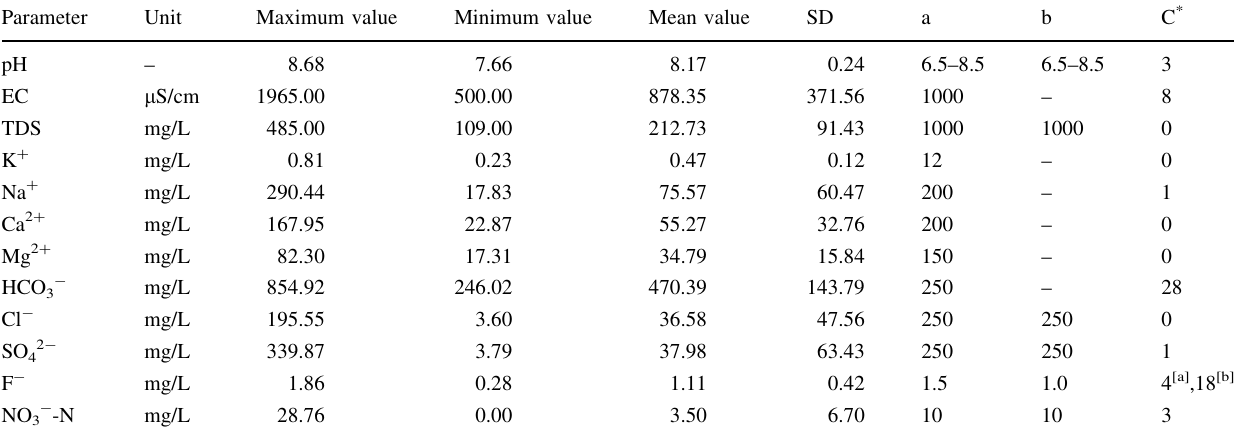
Table 2 Statistical analyses of water quality parameters Parameter